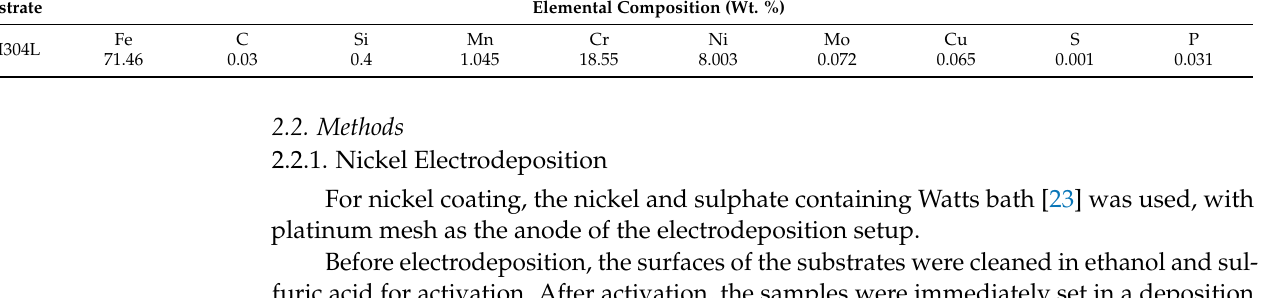
Table 1. The chemical composition of AISI 304 L alloy. Elemental Composition (Wt. %)